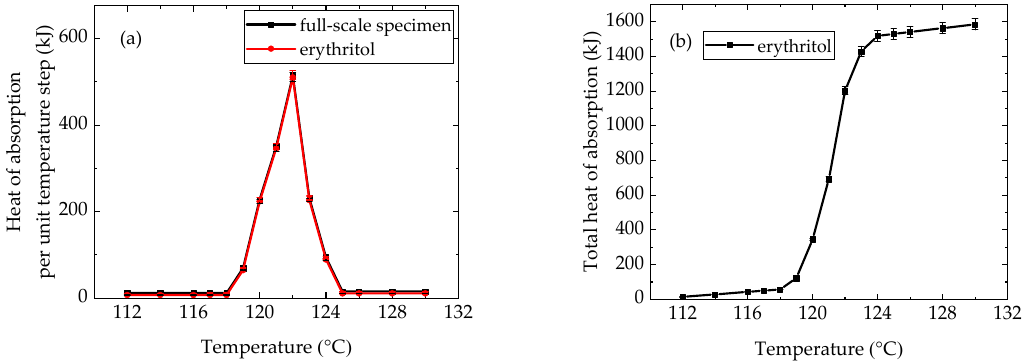
Figure 14. Testing results for heat of absorption of full-scale specimen and erythritol. ( a ) Heat of absorption per unit temperature step. ( b ) Total heat of absorption.